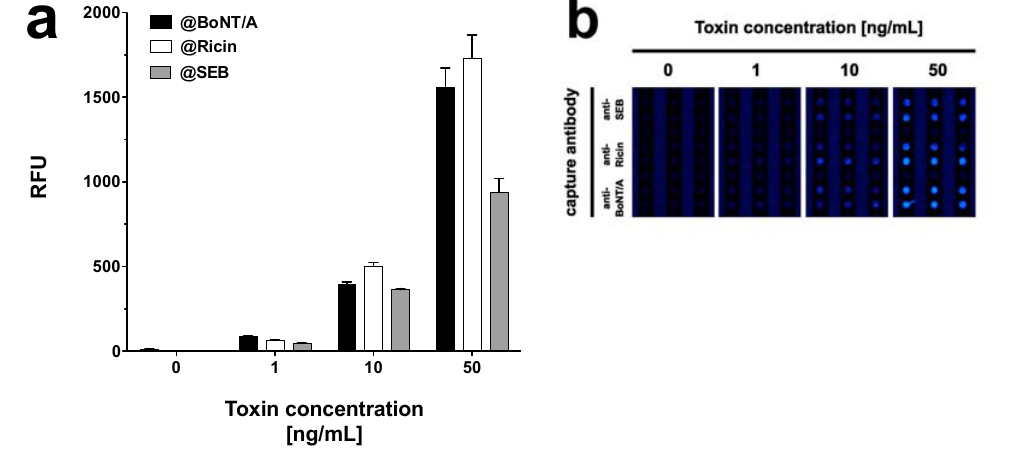
Figure 6. Simultaneous detection of BoNT/A, ricin and SEB in PBS. PBS was spiked with equal concentrations (0, 1, 10, and 50 ng·mL − 1 ) of all three toxins and slides were processed at 37 °C. ( a ) Values are shown for the signals measured at features functionalized with the respective capture antibodies, i.e. , anti-BoNT/A (@BoNTA; black bars), anti-ricin (@Ricin; white bars), and anti-SEB (@SEB; gray bars). Average signal intensities and the standard deviations (error bars) were calculated from six measurements (n = 6) per assay; ( b ) Image series of features functionalized with the highest concentrations for anti-SEB, anti-ricin, and anti-BoNT/A, respectively, and challenged with a mixture of either 0, 1, 10, or 50 ng·mL − 1 of the three